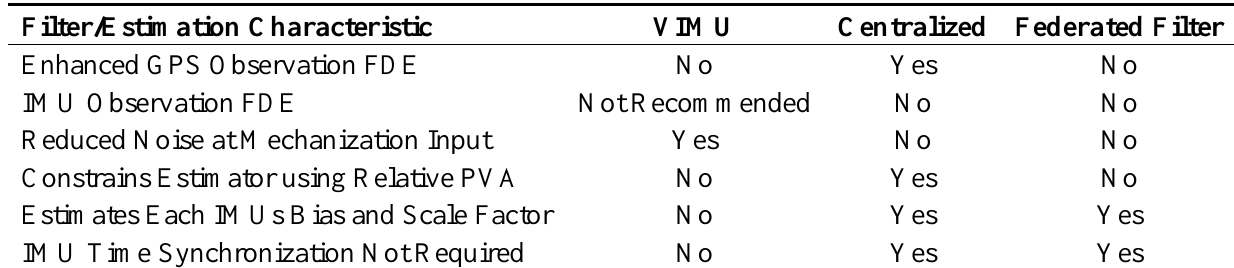
Table 1. Comparison of the Various